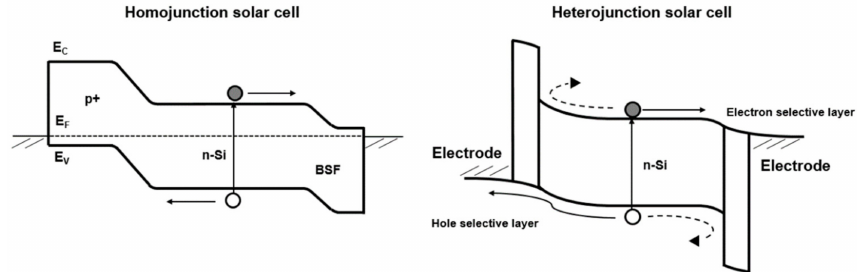
Figure 1. Band diagram of homojunction and heterojunction solar